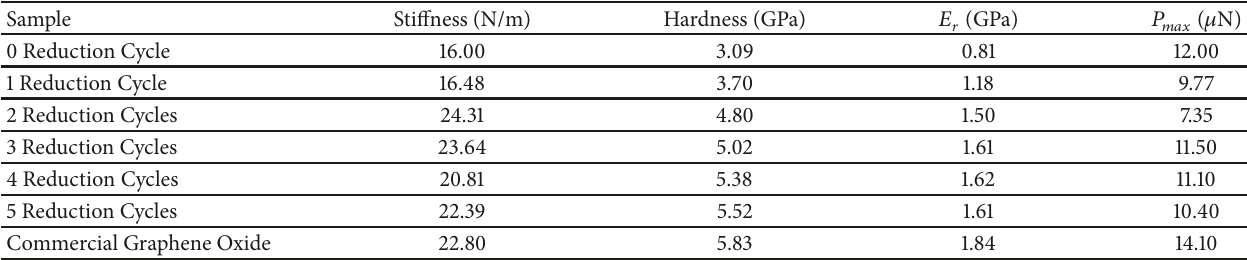
Table 3: The statistical analysis results for spectroscopic investigation of various samples. The values displayed are the averages of the thirty data points taken for each